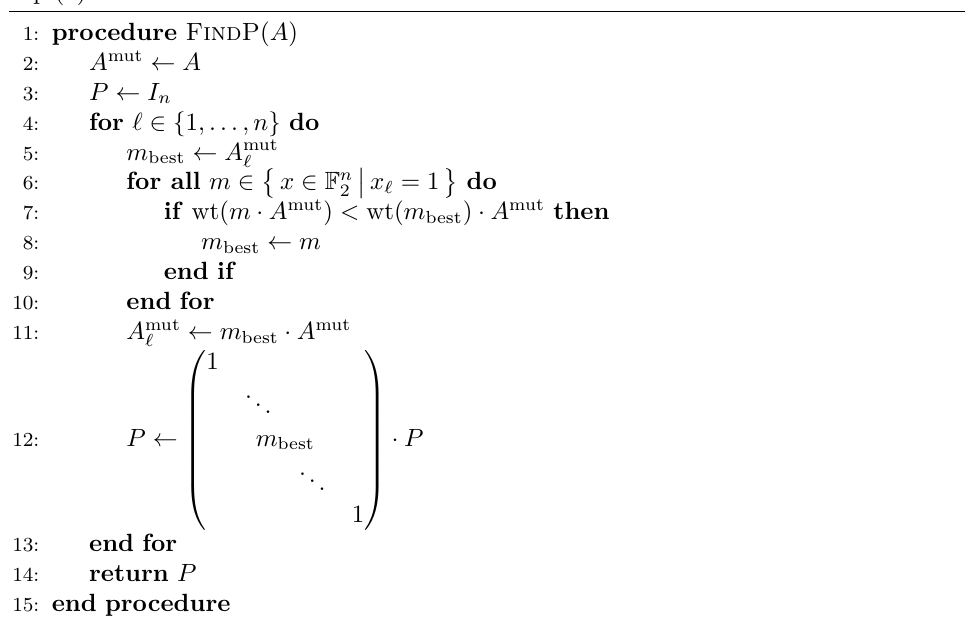
Algorithm 4 Given a binary matrix A of size n × N returns P ∈ GL n ( F 2 ) minimizing Eq.